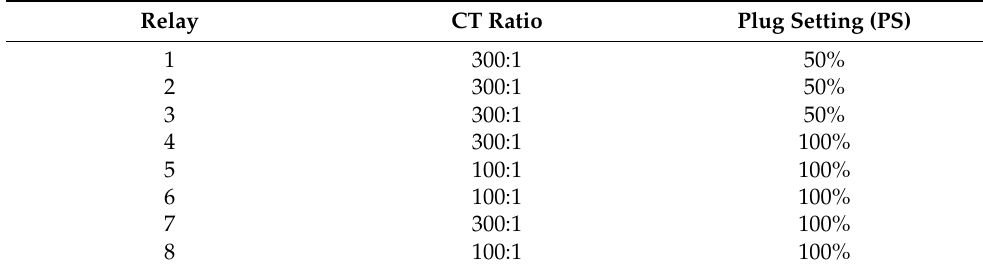
Table 7. Plug settings (PS) and CT ratios of the relays (Case 3).